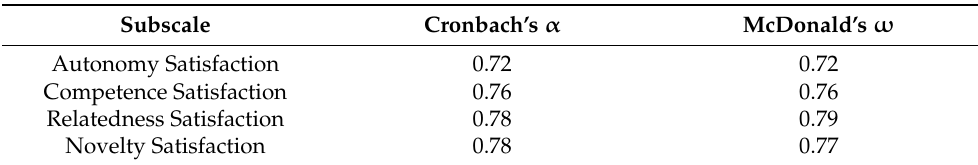
Table 3. Reliability of the four subscales in the BPN-CS as measured by the internal consistency using Cronbach’s α and McDonald’s ω .